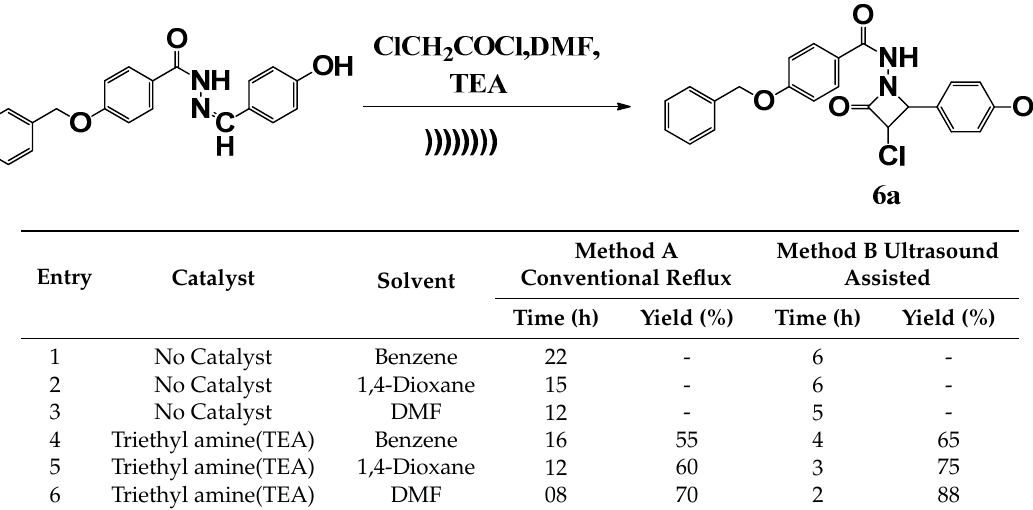
Table 1. Optimization of reaction conditions for 4-(benzyloxy)- N -(3-chloro-2-(4-hydroxyphenyl)-4-